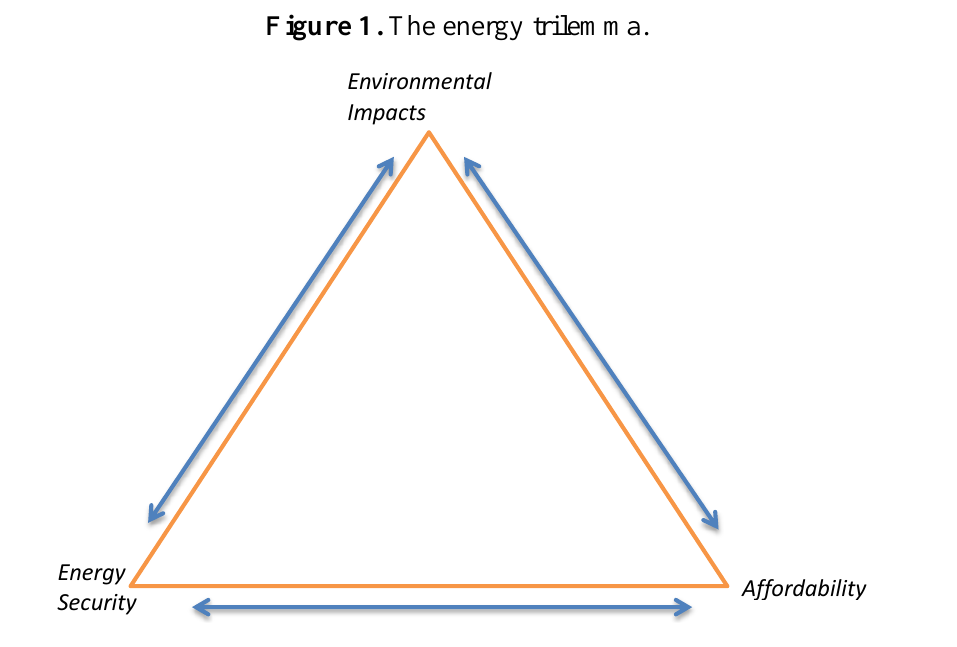
Figure 2. Cumulative and projected CO